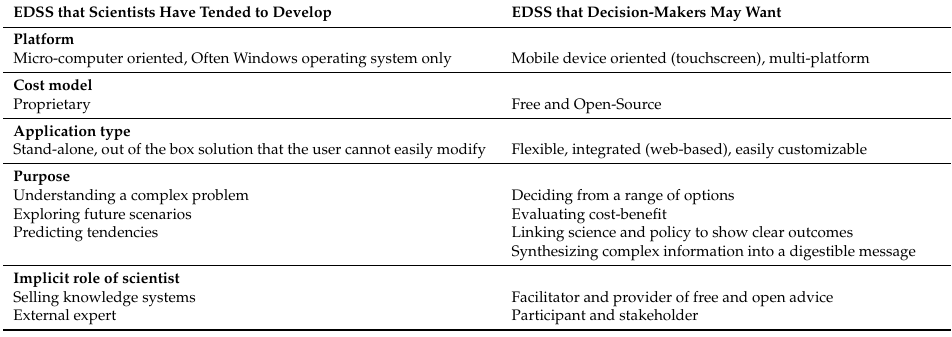
Table 4. The mismatch between EDSS that scientists have tended to develop, and EDSS that environmental decision-makers may